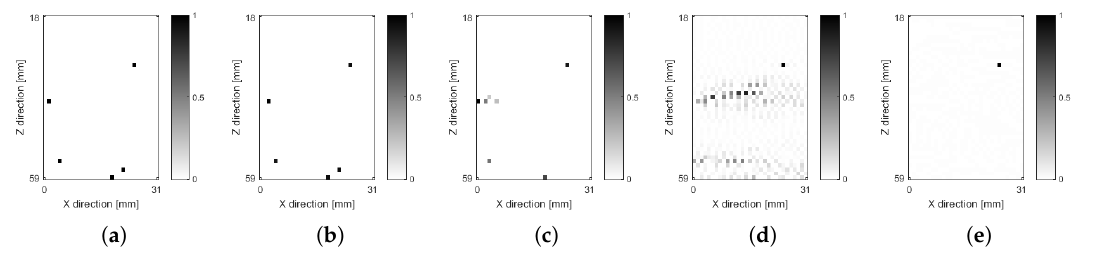
Figure 8. Example of image simulated and reconstructed, from the dataset described in Section 6.1. The simulated data contains five scatterers and white Gaussian noise with σ = 0.08. All images are normalized by the maximum absolute pixel value. ( a ) ground truth, with 5 unity amplitude scatterers randomly distributed over the ROI; ( b ) results from OMPED with the SVD dictionary ( K = 8). The algorithm correctly identified the 5th iteration as the final one; ( c ) results from OMP with regular model H . Seven iterations were run to show that, after the 4th iteration, the algorithm creates artifacts on the neighborhood of the leftmost scatterer instead of identifying the bottom-right scatterer present on the ground truth image. ( d ) Solution of the unregularized LS problem of Equation (4). The image is dominated by artifacts; ( e ) solution of the (cid:96) 1 -regularized problem of Equation (28). The penalization of the recovered amplitudes causes the suppression of most points on the resulting image. The chosen regularization parameter λ = 2.0691 minimizes the norm (cid:107) v − ˆ v (cid:107) , where v is the ground